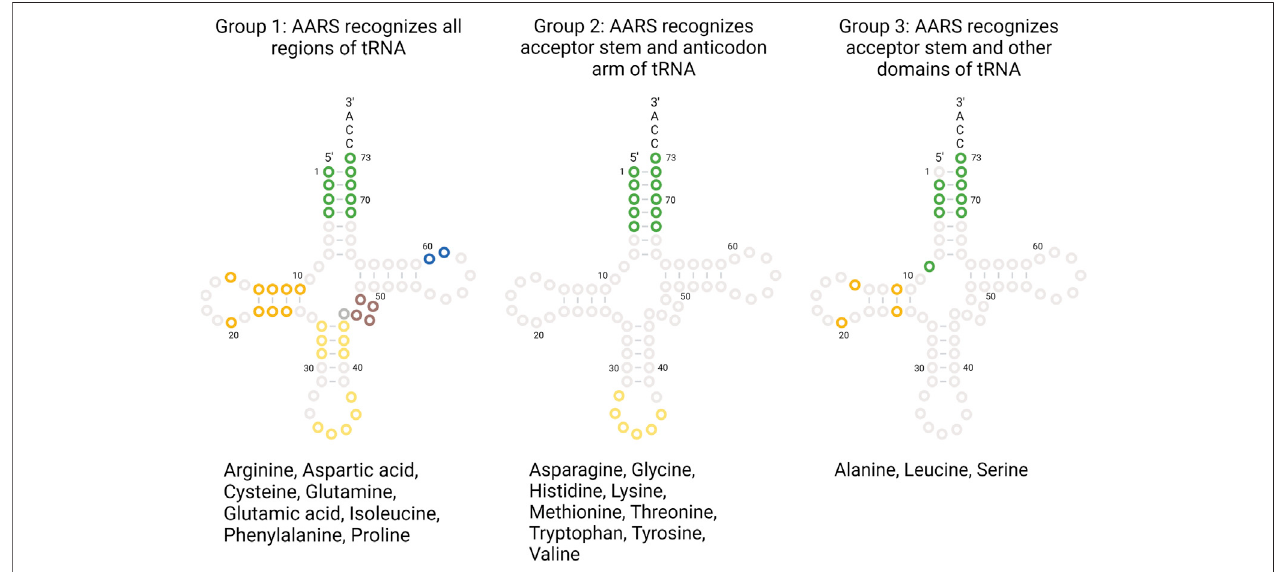
FIGURE 3 | AARS identity elements on tRNA. AARSs are grouped based on the location of the identity elements present on tRNA regions. The list of AARS under each group and the tRNA bases utilized for recognition are highlighted.